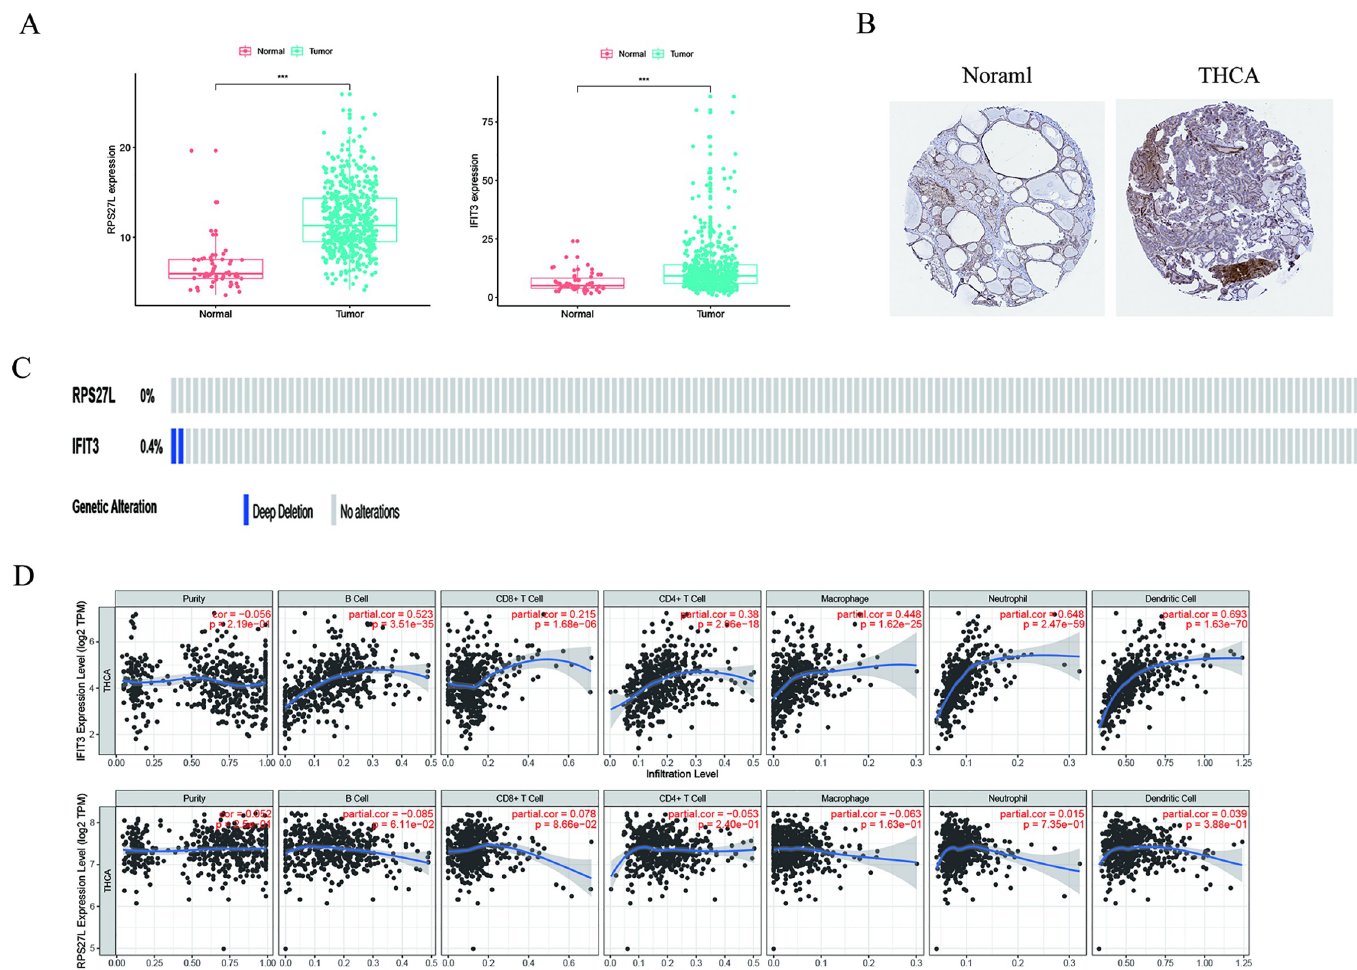
Fig 8. Validate and analyze the RBP-coding genes. (A) RPS27L and IFIT3 were highly expressed in THCA (TCGA, p ��� < 0.001); (B) IFIT3 was highly expressed in THCA (HPA); (C) RPS27L and IFIT3 mutations were very low; (D) Correlation analysis between gene expression and immune